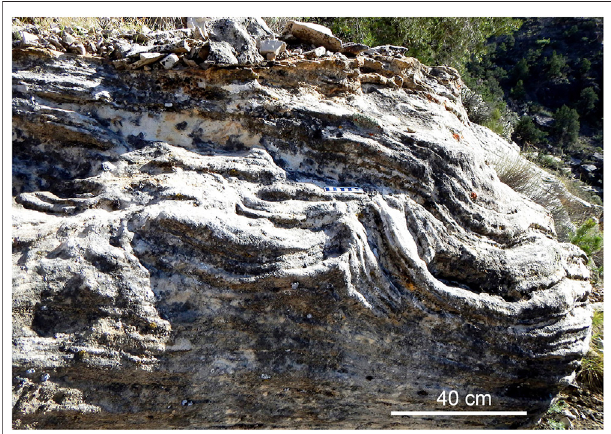
FIGURE 12 | Contorted bedding observed near the Tuweep ranger station. The deformation zone here is thicker than most of the others described in this paper.